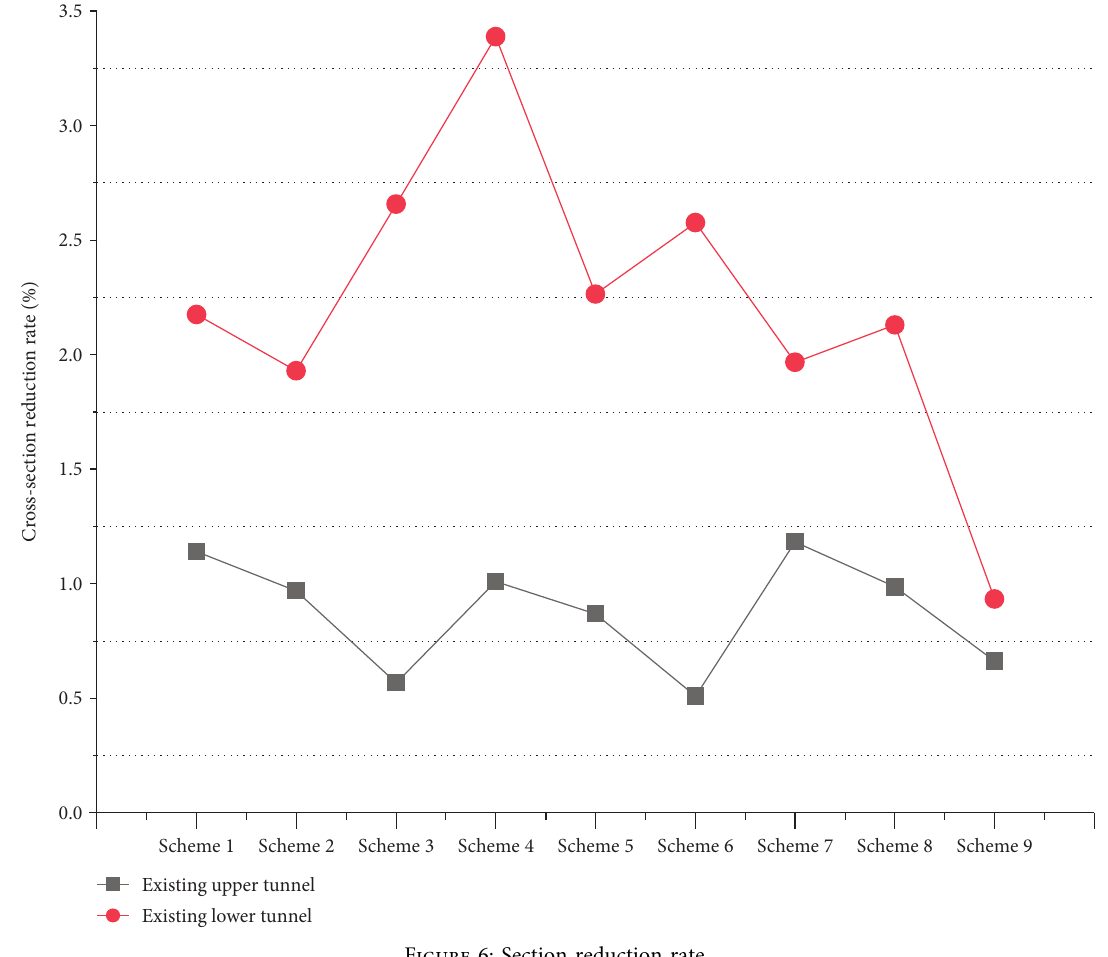
Figure 6: Section reduction